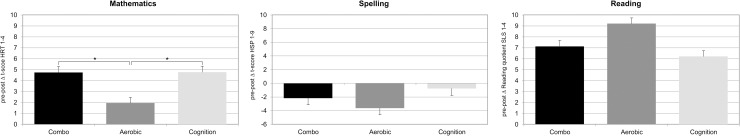
Means and error bars (representing the standard error of the mean) for the change (Δ) in the three academic achievement tests (mathematics, spelling,reading) in the three groups between pre- and post-test.*p < .05.